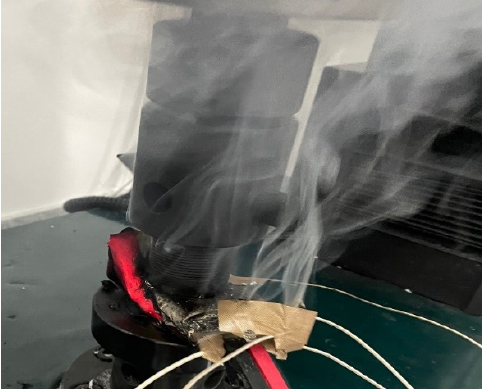
Figure 17. Side cracking of the cell during extrusion.